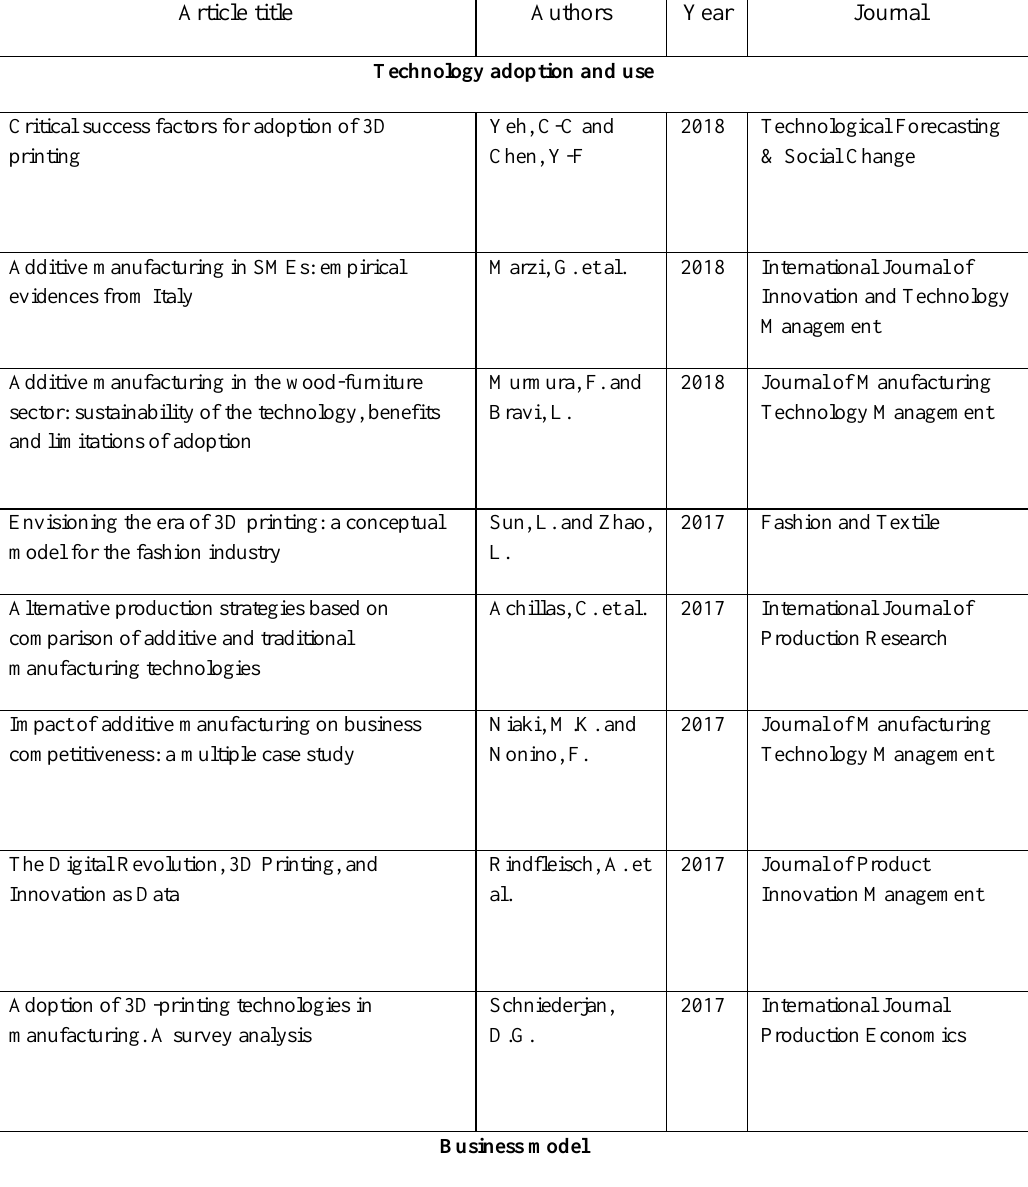
Table 1 : List of Selected Articles Sorted by Themes and Year of